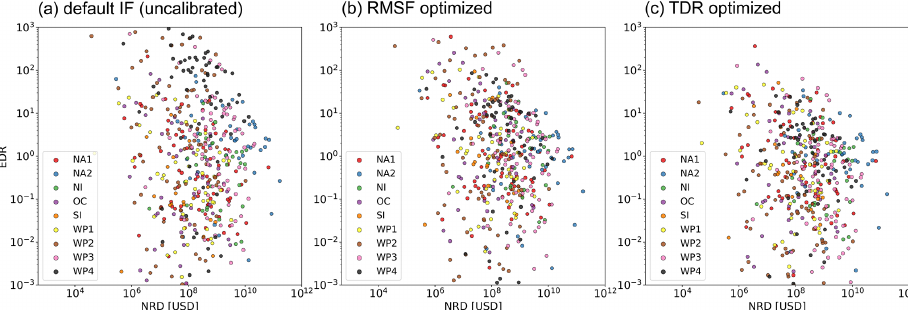
Figure A3. No significant correlation between event damage ratio (EDR) and normalized reported damage (NRD) was found. The scatter plots show the relationship for 473 TC events worldwide computed with three different sets of impact functions: (a) uncalibrated default ( V half = 74.7ms − 1 ), (b) RMSF optimized, and (c) TDR optimized. The nine calibration regions are differentiated by color.